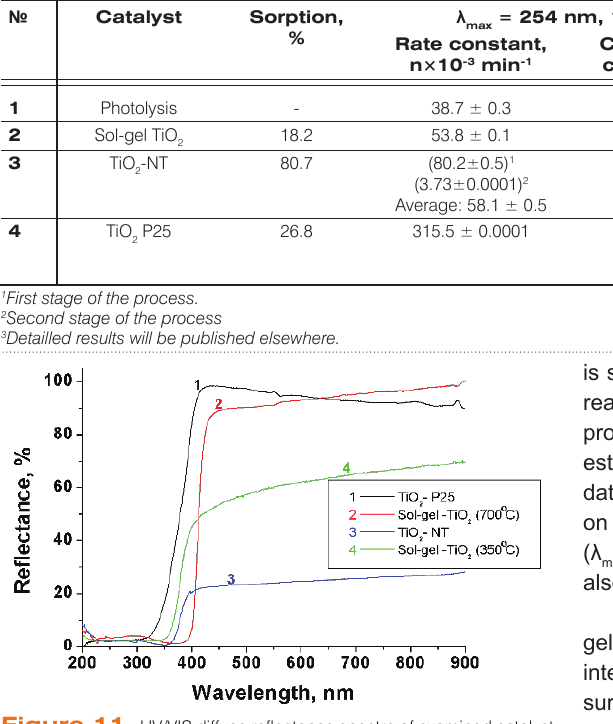
Figure 11. UV/VIS diffuse reflectance spectra of examined catalyst samples.